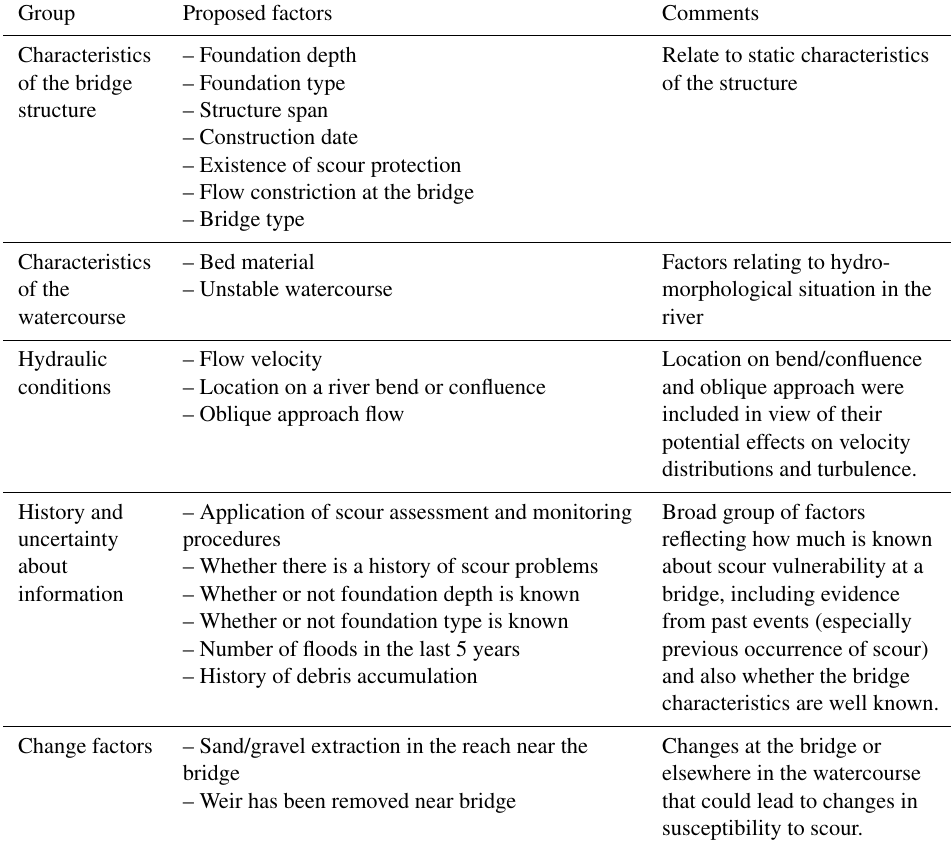
Table 2. Proposed vulnerability factors.